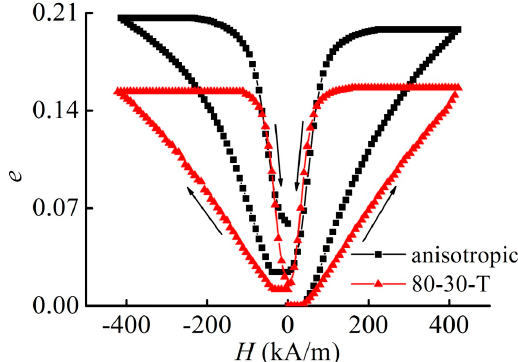
Figure 9. Comparison of the magnetostrictive strain of an anisotropic sample with 80 mass% of iron with the corresponding isotropic sample showing the largest magnetostrictive strain.